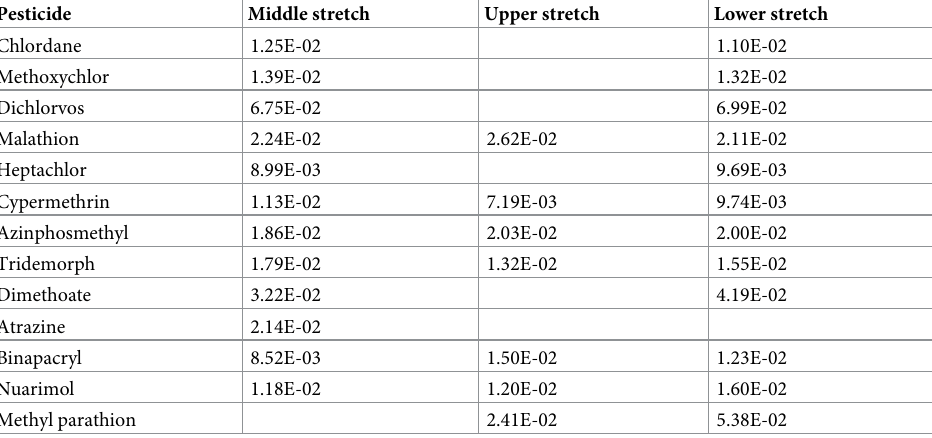
Table 4. Risk assessment of pesticide residues in sediment samples based on toxic units